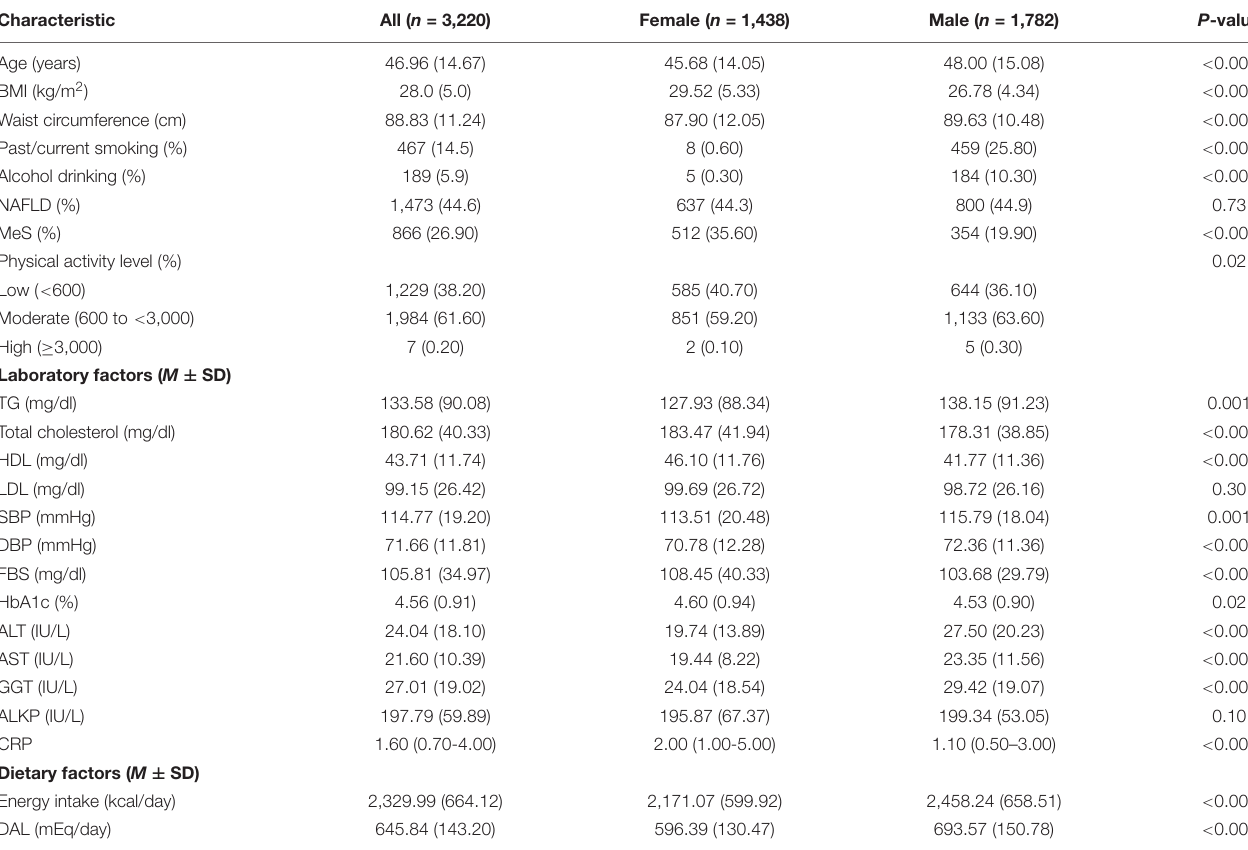
TABLE 1 | Characteristics of the study population by gender in Iranian adults of AmolCS. Characteristic All ( n = 3,220) Female ( n = 1,438)